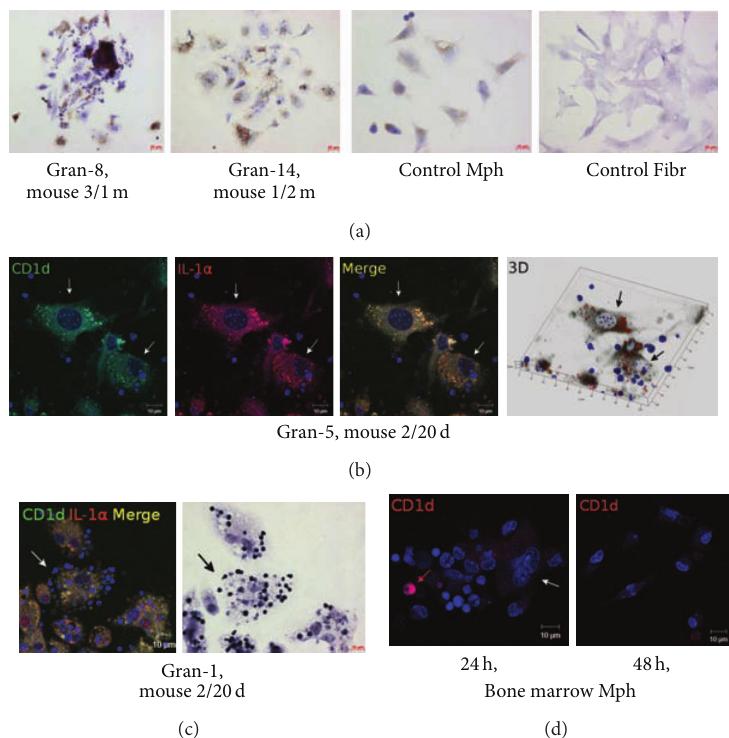
Figure 7: ((a)–(c)) Bacterial lipid- and glycolipid-presenting molecule CD1d in the cells in the fragments of mouse splenic granulomas. The scale bars are ((a, central right panel), (b)–(d)) 10 𝜇 m each and (a, other panels) 20 𝜇 m each. ((b)-(c)) Colocalization of the markers on the confocal images of cells (yellow signal). ((b)–(d)) Nuclei stained by DAPI (blue signal). (a) Immunochemical localization of CD1d in granuloma cells, control mouse peritoneal macrophages (Mph), and fibroblasts (Fibr). The brown color indicates the presence of CD1d in these cells. ((b)-(c)) Confocal immunofluorescent localization of CD1d (green signal) and IL-1 𝛼 (red signal) in granuloma macrophages and fibroblasts. (b) CD1d- and IL-1 𝛼 -producing fibroblasts are indicated by the white arrows on the fluorescent images and the black arrows on the 3D image. (c) In the right panel, the same fragment as in the left panel restained for acid-fast BCG-mycobacteria by the ZN method. A CD1d- and IL-1 𝛼 -producing macrophage with BCG-mycobacteria reproducing in it is indicated by the white arrow on the fluorescent image and the black arrow on the ZN image. (d) Confocal immunofluorescent localization of CD1d (red signal) in the cells in the cultures of bone marrow macrophages following infection with the BCG vaccine in vitro and after culture for several hours. The macrophage with CD1d in it is indicated by the red arrow, and a megakaryocyte without the antigen is indicated by the white arrow. Abbreviations as in Figure 1.